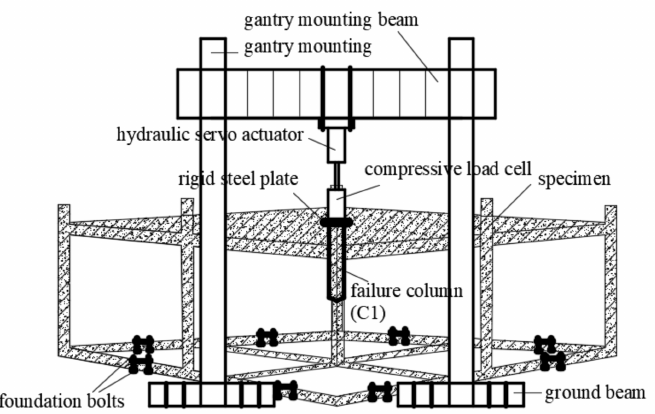
Figure 4. The test setup and RC